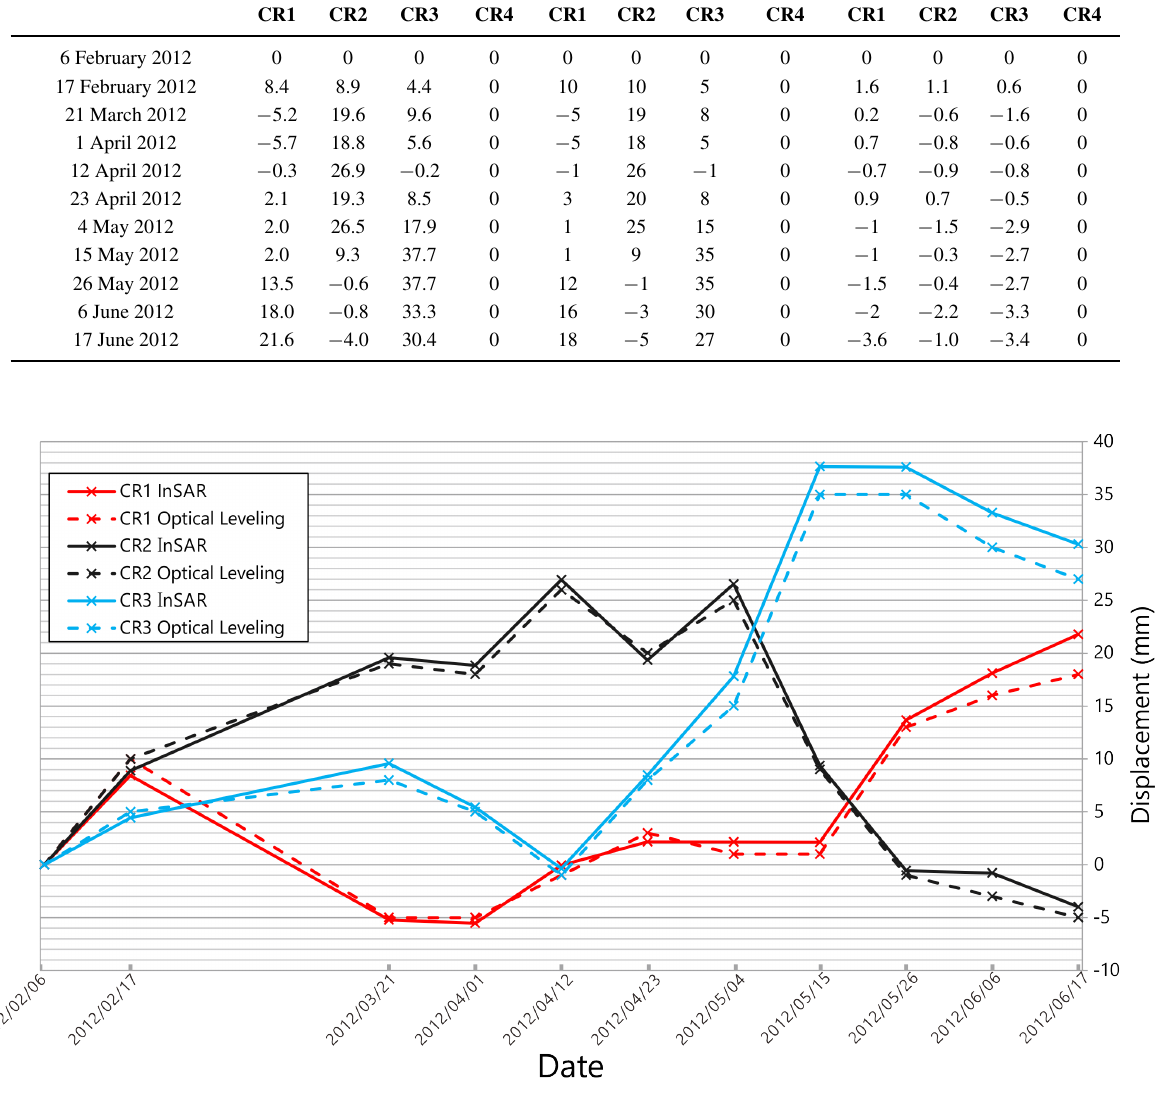
Date of Satellite Images